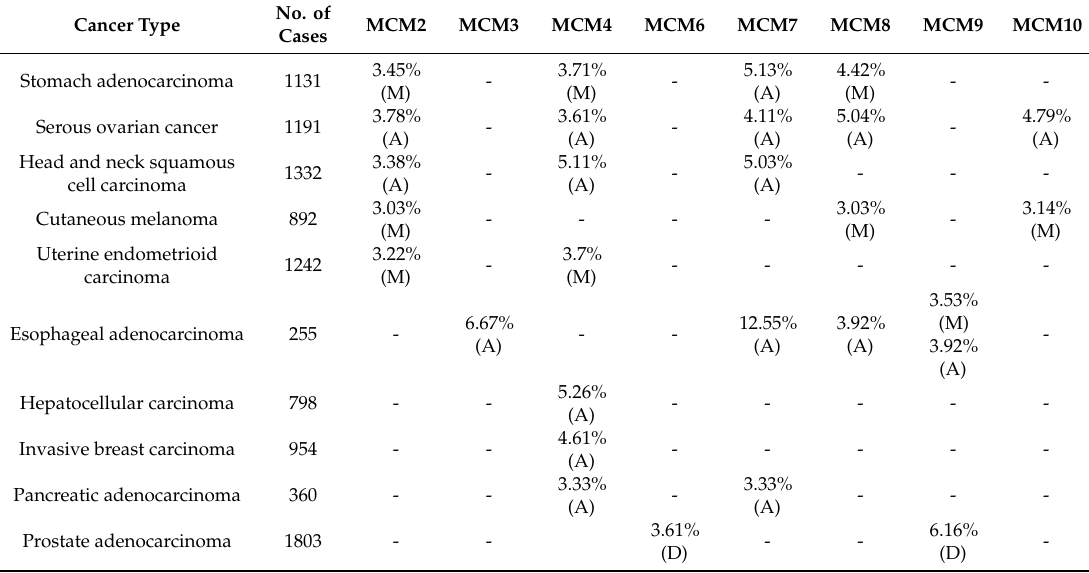
Table 2. Alterations in MCM genes in human